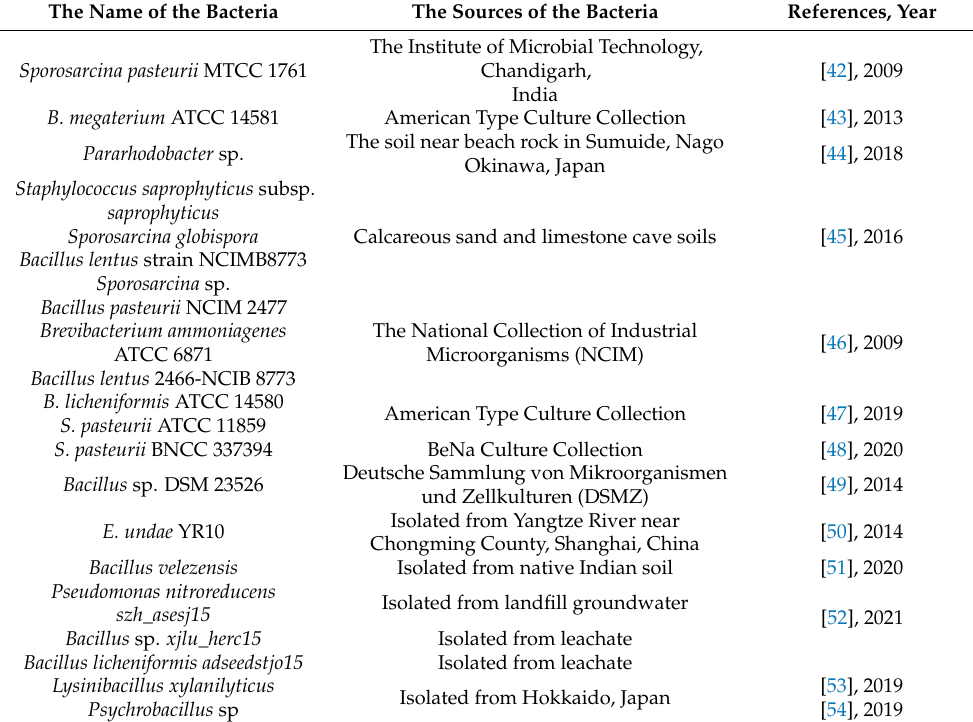
Table 1. MICP research using various urea-producing